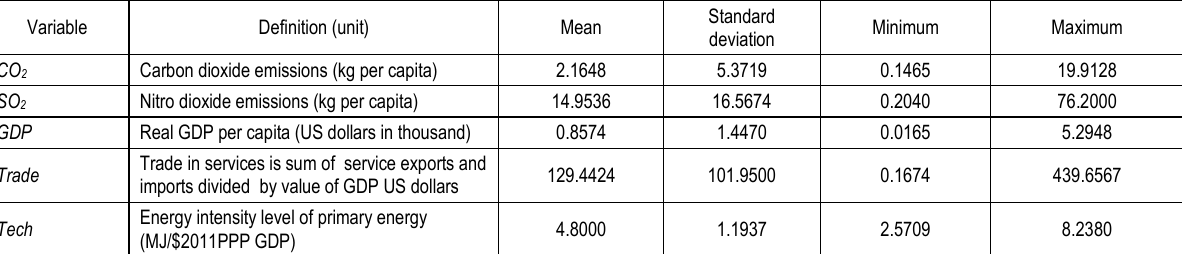
Table 2. Definition and descriptive statistics of the variable for